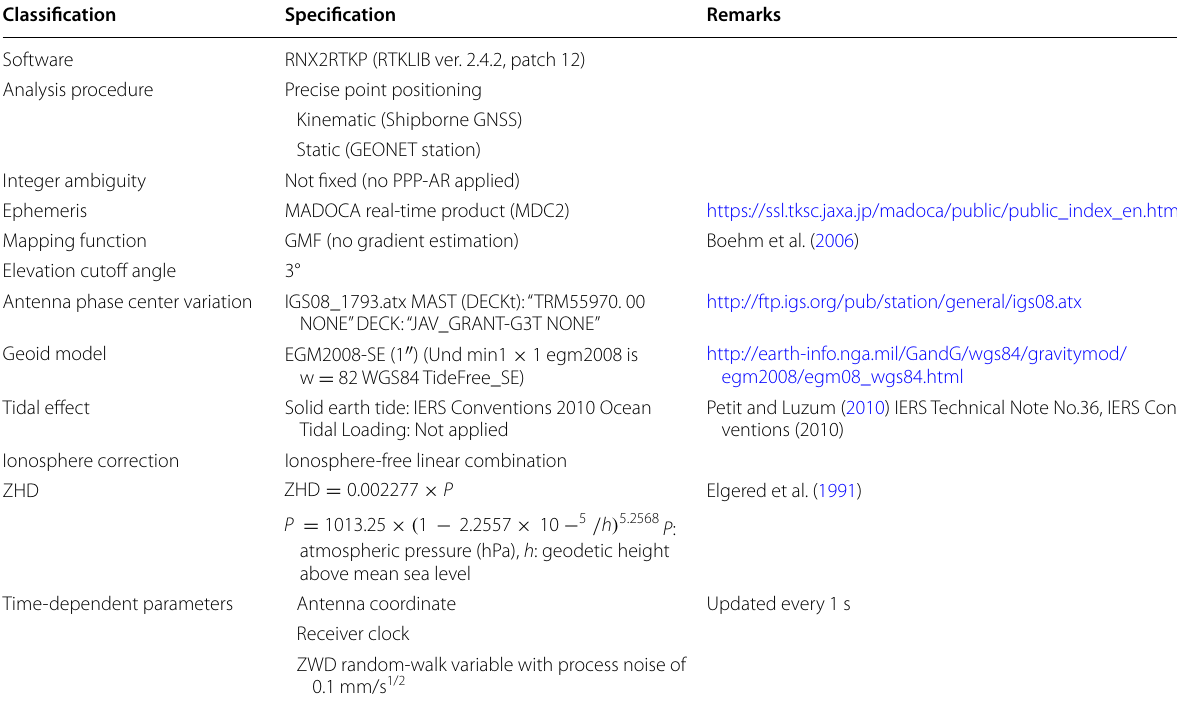
Table 2 Main specifications of the GNSS